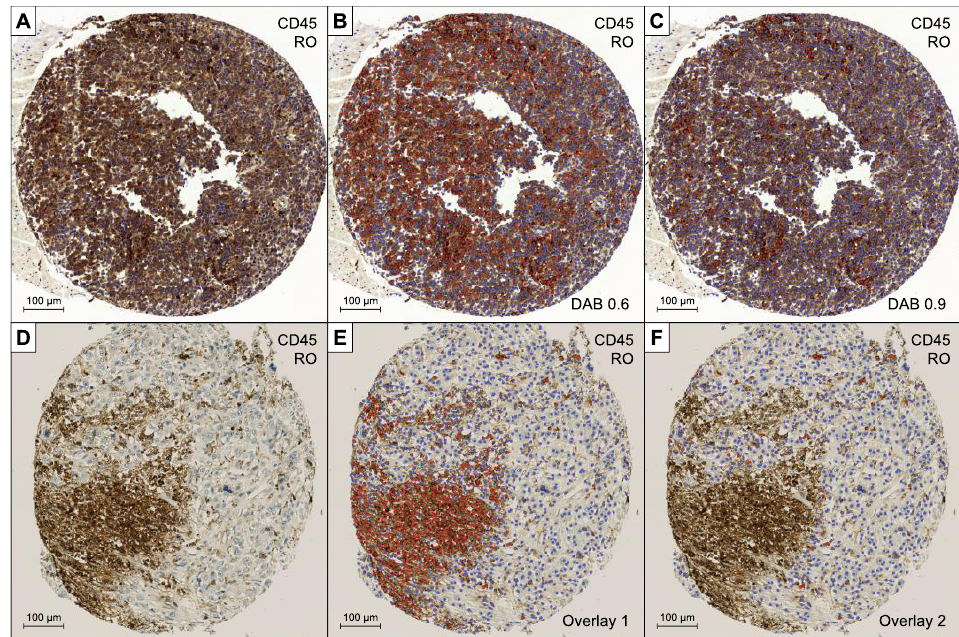
Figure 2. Staining of CD45RO: ( A ) Strong cytoplasmic staining in tumor cells. ( B ) Automated evaluation “overlay”. ( C ) Manually altered threshold for the automated evaluation. ( D ) Diffuse staining of necrotic area. ( E ) Automated evaluation “overlay”. ( F ) Manually altered staining area. Table 2. Univariable Cox-Regression